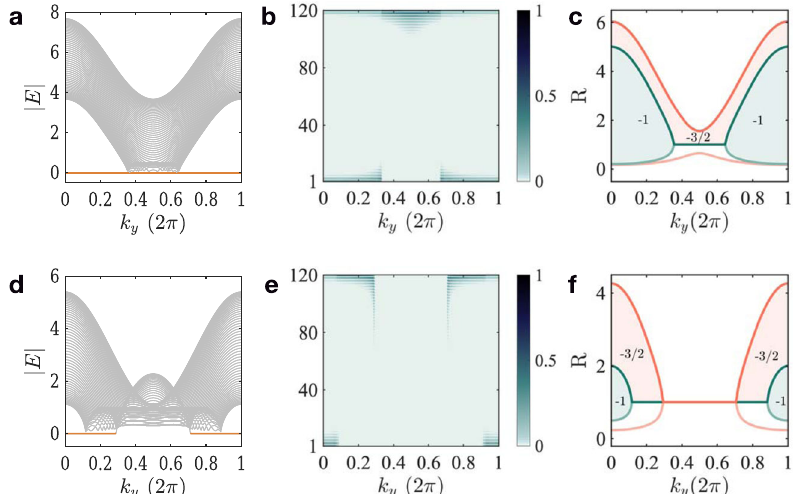
Fig. 3 Topological behaviors of the effective one-dimensional tight-binding model under open boundary condition. a – c Show the results for phase I with hopping parameters t 0 / t 1 = 1.85, γ 0 / t 1 = 0.25, and ( d - f ) show the results for phase IV with t 0 / t 1 = 0.75, γ 0 / t 1 = 0.5. a , d The absolute values of the energy spectra ∣ E ∣ for k y ∈ (0, 2 π ) with on-site energy ε 0 = 0, where gray and orange lines denote bulk modes and topological boundary modes, respectively. b , e The absolute values of the normalized amplitude of the localized topological boundary modes with N = 60 unit cells (2 N sites) along x direction. c, f ∣ a ∣ , ∣ a ∣ , ∣ b ∣ , ∣ b ∣ curves are colored by red, light red, dark green and light green, respectively, where a 1 2 1 2 numbers W ( R ) satisfy the condition of topological boundary